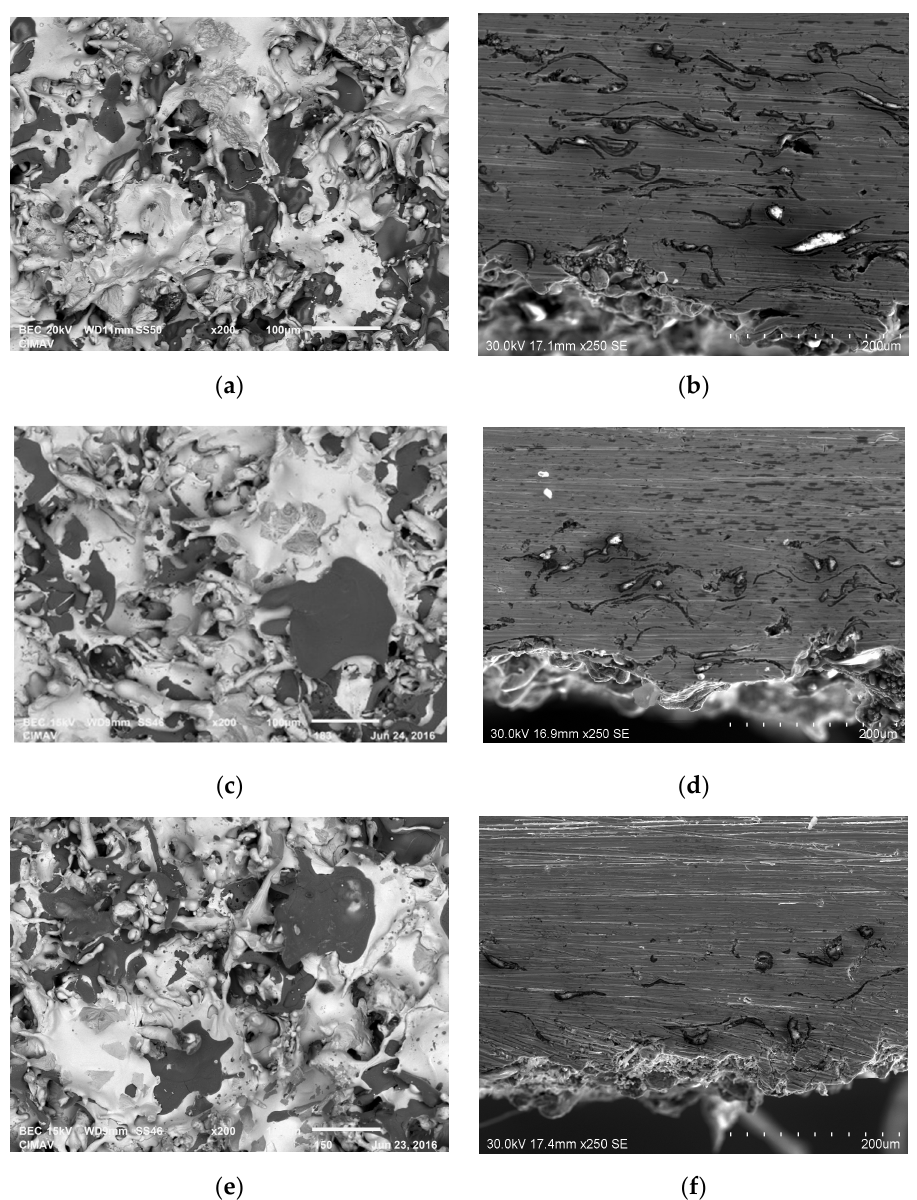
Figure 2. ( a ) Scanning electron microscopy (SEM) morphology of coatings produced with 331 kPa oxygen and 69 kPa acetylene; surface micrography and ( b ) cross section micrography. ( c ) SEM morphology of coatings produced with 345 kPa oxygen and 83 kPa acetylene; surface micrography and ( d ) cross section micrography. ( e ) SEM morphology of coatings produced with 359 kPa oxygen and 97 kPa acetylene; surface micrography and ( f ) cross section micrography.